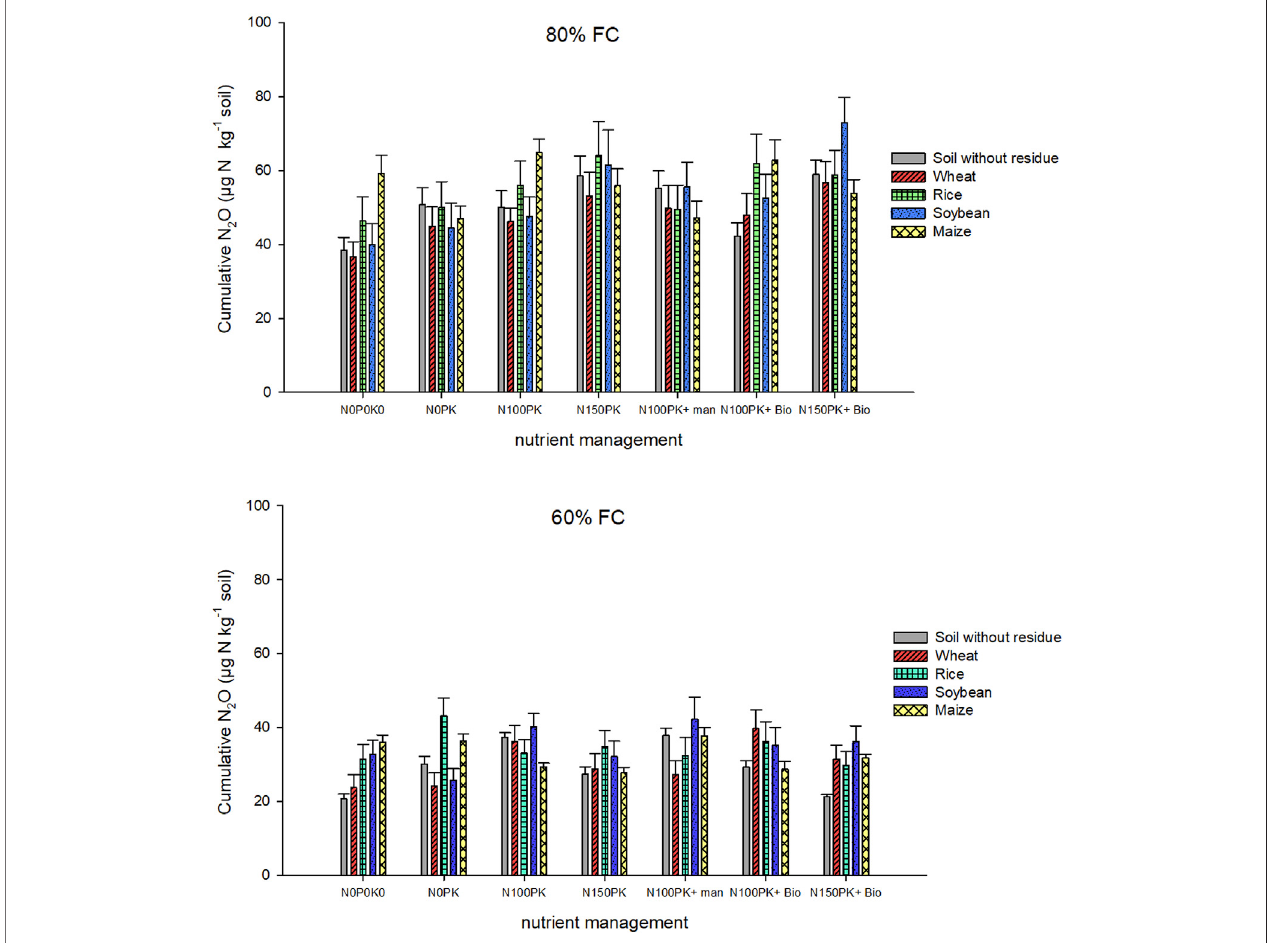
FIGURE 2 | Cumulative soil nitrous oxide fl ux (µg-N kg − 1 soil) as in fl uenced by residue types, nutrients, and soil moisture after 87 days of incubation. Details of cumulative N 2 O fl ux statistics are provided in Tables 3 , 4